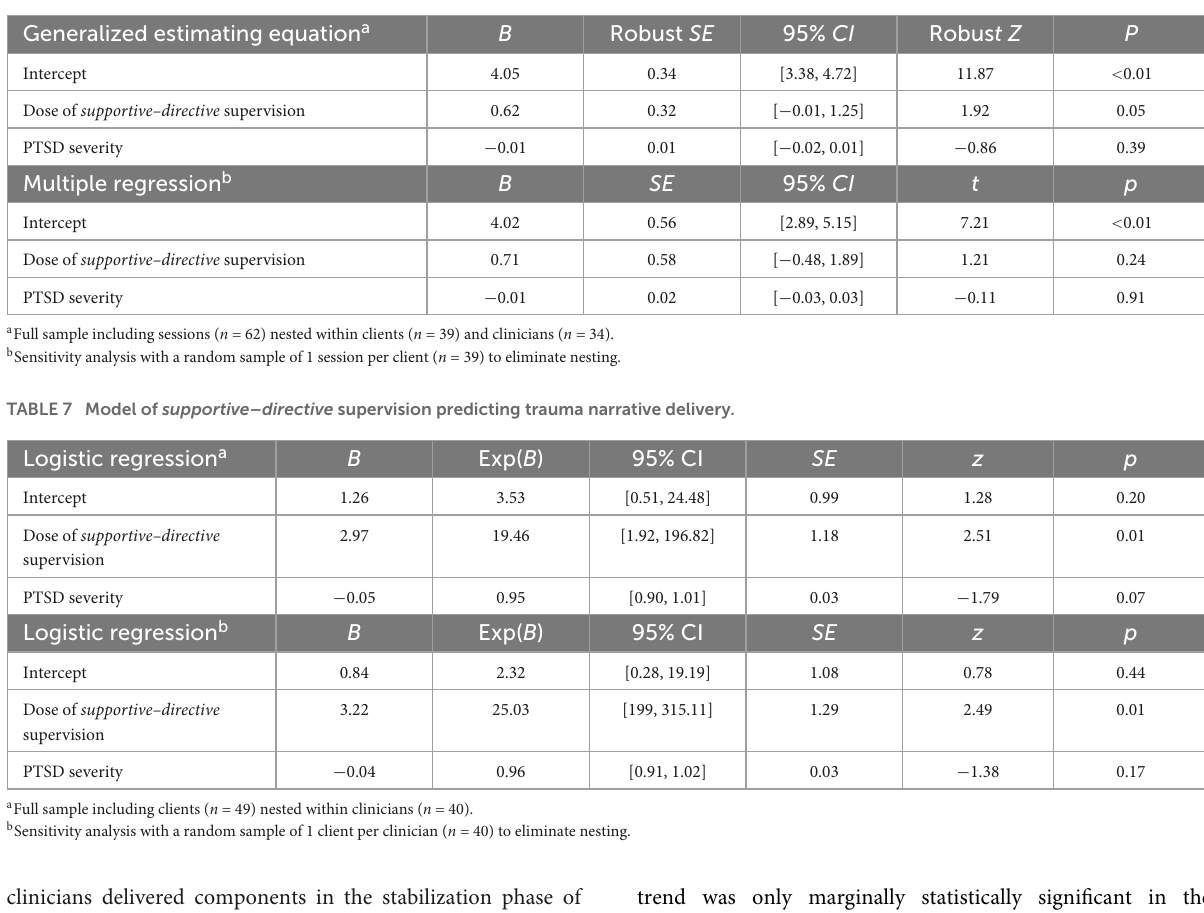
TABLE 6 Model of supportive–directive supervision predicting trauma-focused cognitive behavioral therapy stabilization scores. Generalized estimating equation a